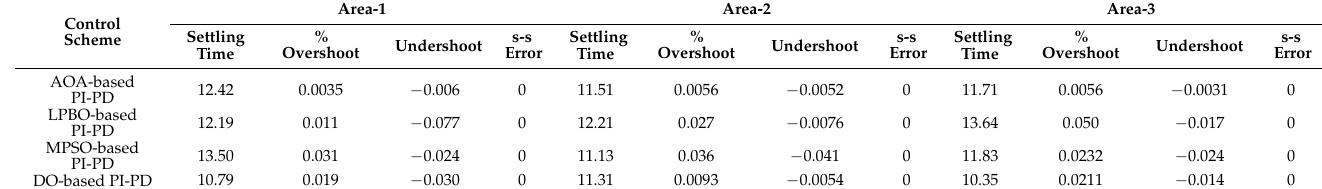
Table 15. Numerical results of tie-line power deviation in a three-area multi-source IPS with nonlinearities.